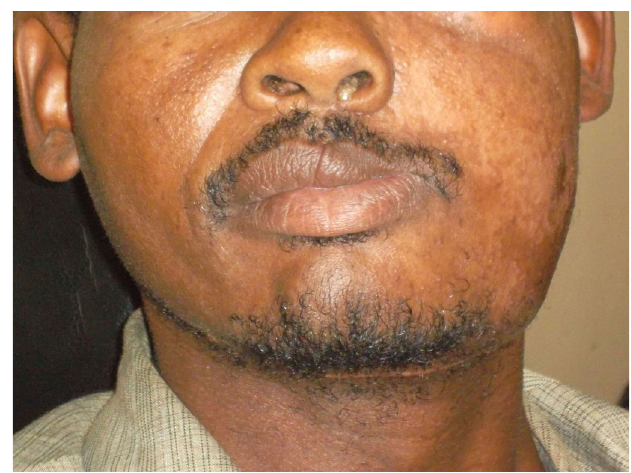
Fig. 1. Facial asymmetry in a patient with orbital fl oor bone grafting and prosthetic obturator after a type 3